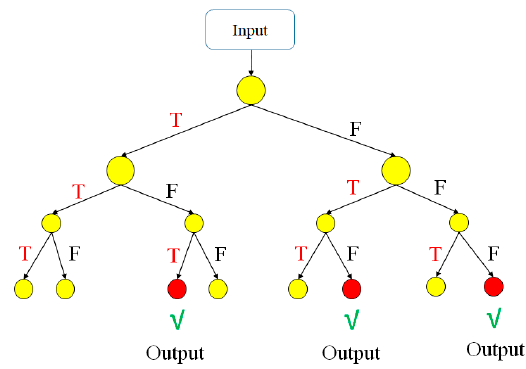
Figure 7. Conceptual representation of decision tree.